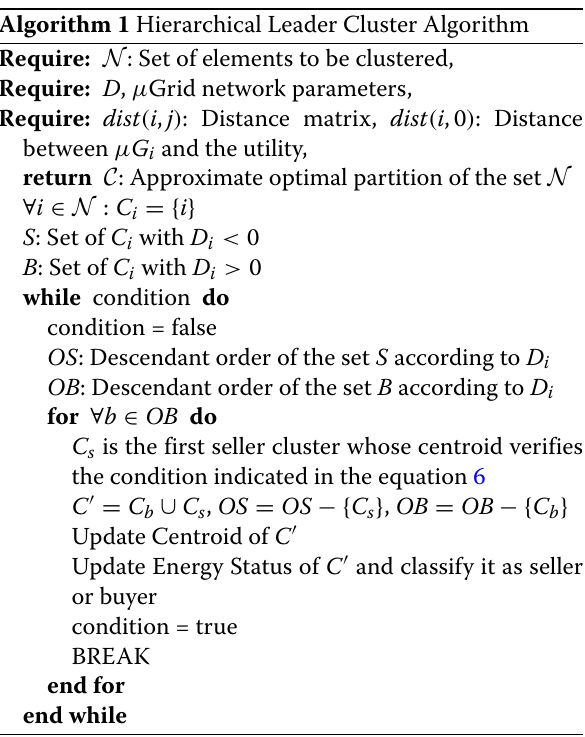
The Algorithm 1 highlights the main steps of the adjusted clustering algorithm.